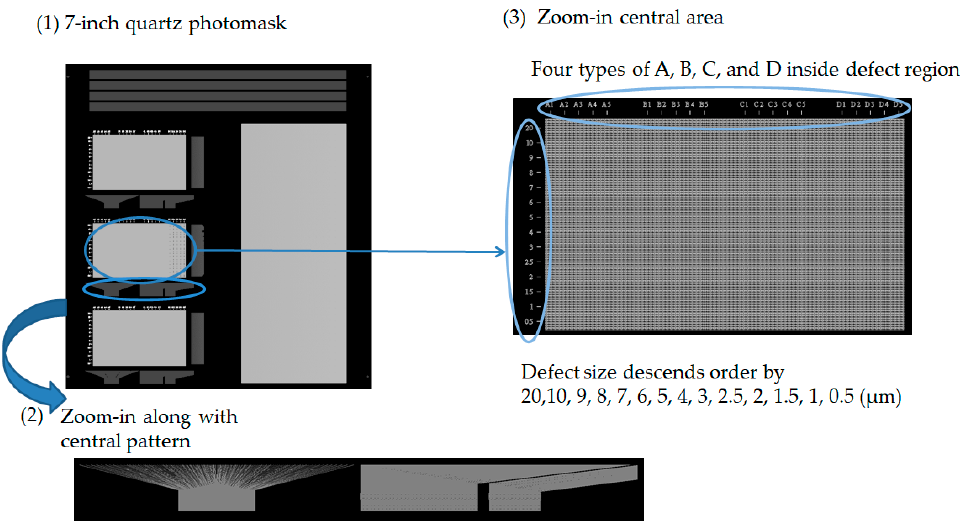
Figure 11. Illustration of the central area for a 7-inch quartz mask: (1) a 7-inch quartz pattern; (2) a zoom-in along with the central pattern; and (3) the zoom-in on the central area .